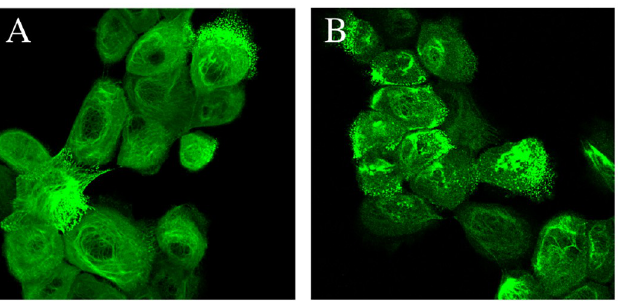
Fig 3. Proteasome inhibition leads to the accumulation of fluorescently labeled keratin aggregates. (A) EGFP-K14 R125P cells before treatment with MG132 proteasome inhibitor. Aggregates are visible only within some cells. Aggregates are visible only in about 10% of cells. (B) EGFP-K14 R125P cells after 2 hours of treatment with 1 μ M MG132. Aggregates are present in 99% of cells, indicating that the proteasome system has a leading role in the turnover of these aggregates.